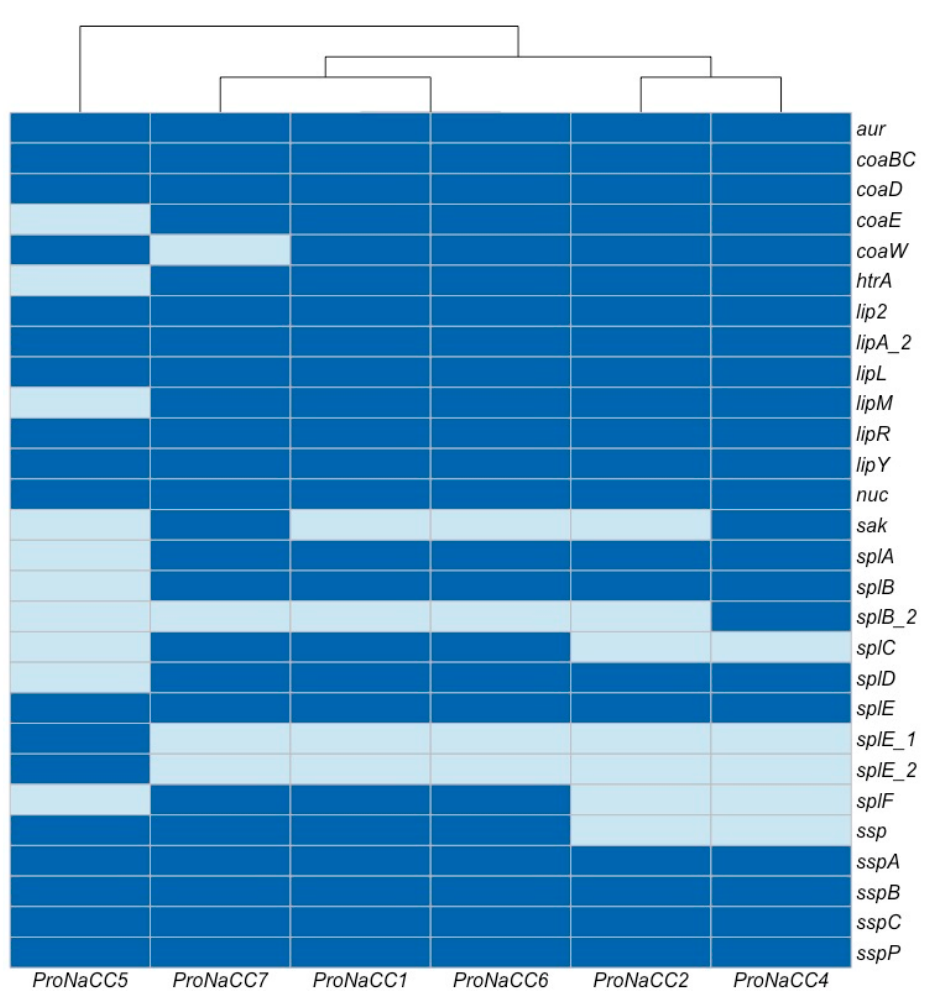
Figure 3. Heat map showing the exoenzymes genes among the six enterotoxigenic S. aureus strains (dark blue: sequence detected; light blue: sequence not detected).